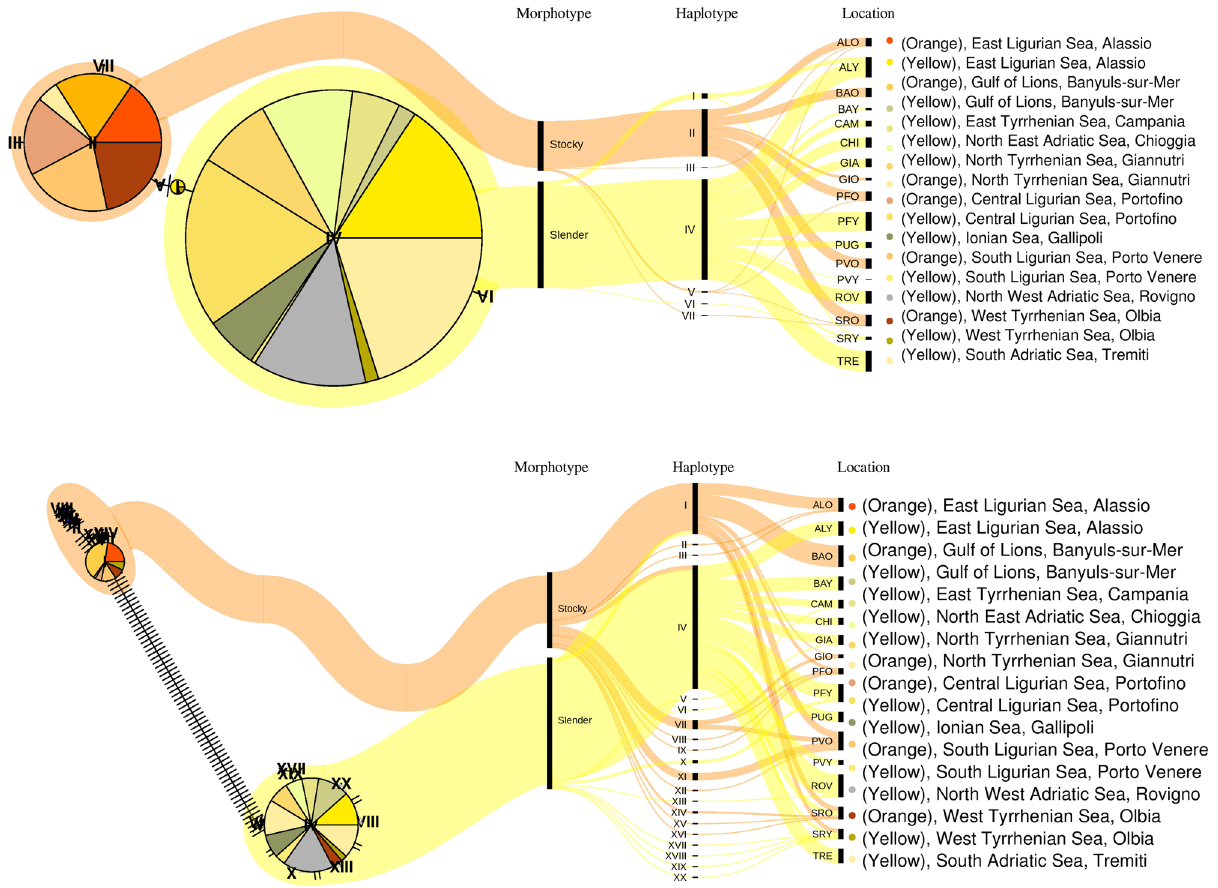
Figure 2. Haplotype network analysis for COI (above) and ITS (below) gene markers in Parazoanthus axinellae species complex. Haplotype network was built in Rstudio version 1.1.453 (https ://rstud io.com/) with an R package pegas (https ://cran.r-proje ct.org/web/packa ges/pegas /index .html), using an infinite site model based on Hamming distances of DNA sequences. Each haplotype is presented as a separate pie chart, and size of the pie charts directly correlates to the number of individuals within the haplotype. Pie chart colors for geographic location were chosen to intuitively associate the reader to Parazoanthus axinellae morphotypes, with orange tones being attributed to the “Stocky” morphotype, and yellow and grey tones to the “Slender” morphotype. Distances between haplotypes correspond to the genetic differentiation observed for each of the markers, and each mutation between the haplotypes is shown as a hyphen. Alluvial diagrams were made using an online platform RAWGraphs (https ://rawgr aphs.io/) to further clarify haplotype-morphotype assignments, and final graph modifications were done in Inkscape version 0.92.4 (https ://inksc